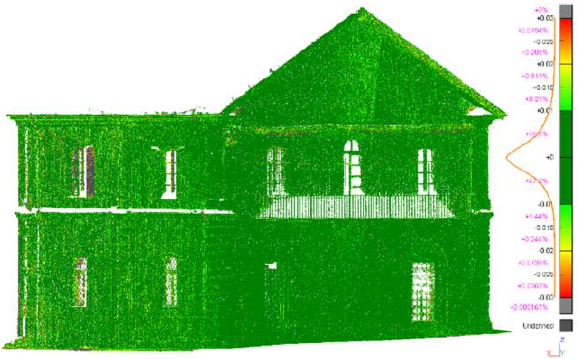
Figure 9. Cloud-to-Cloud comparison (Calantropio et al., 2018)